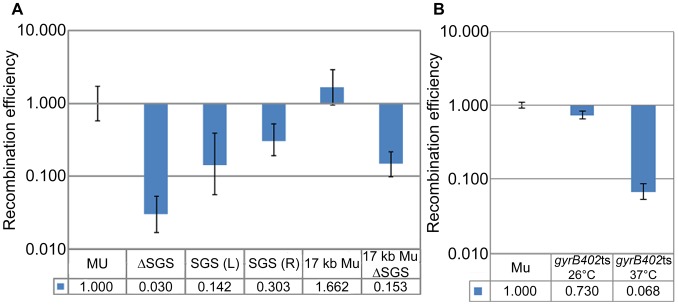
Importance of SGS and DNA supercoiling to Mu end synapsis.(A) RE of loxP sites flanking Mu in SGS-deleted, SGS-displaced to left (L) or right (R) of center, and reduced-Mu genome strains. MU (ZL524), ΔSGS (ZL562), SGS(L) (ZL573), SGS(R) (ZL578), 17 kb Mu (RS020), 17 kb ΔSGS (RS025). (B) RE of loxP sites flanking a Muc+ lysogen (ZL911) and its isogenic gyrBts strain (ZL941) measured at 26°C and 37°C, using the rhamnose-inducible Cre plasmid as described under Materials and Methods. Other descriptions as in Figure 1.